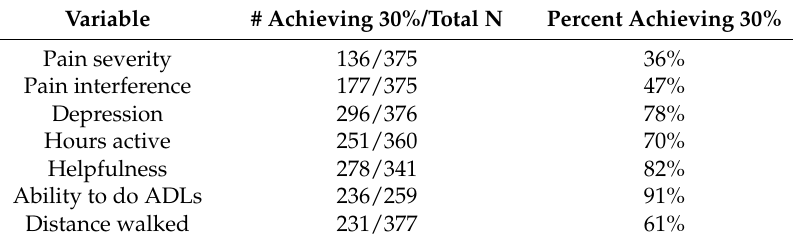
Table 4. Percent of patient’s achieving 30% or greater